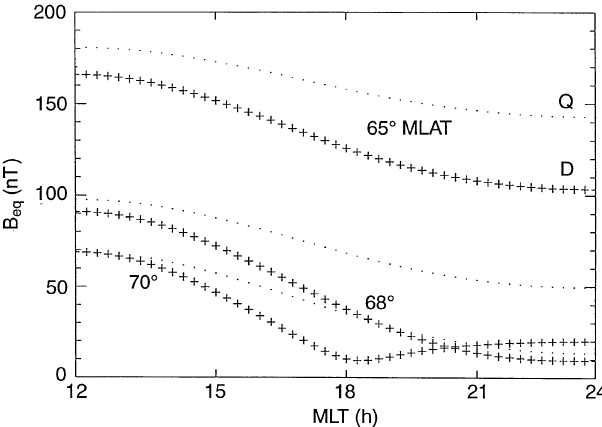
Fig. 2. Magnetic-field intensity at the equatorial plane versus local time for 65 ° , 68 ° , and 70 ° MLAT field lines for quite ( dots ) and for disturbed ( crosses ) magnetosphere